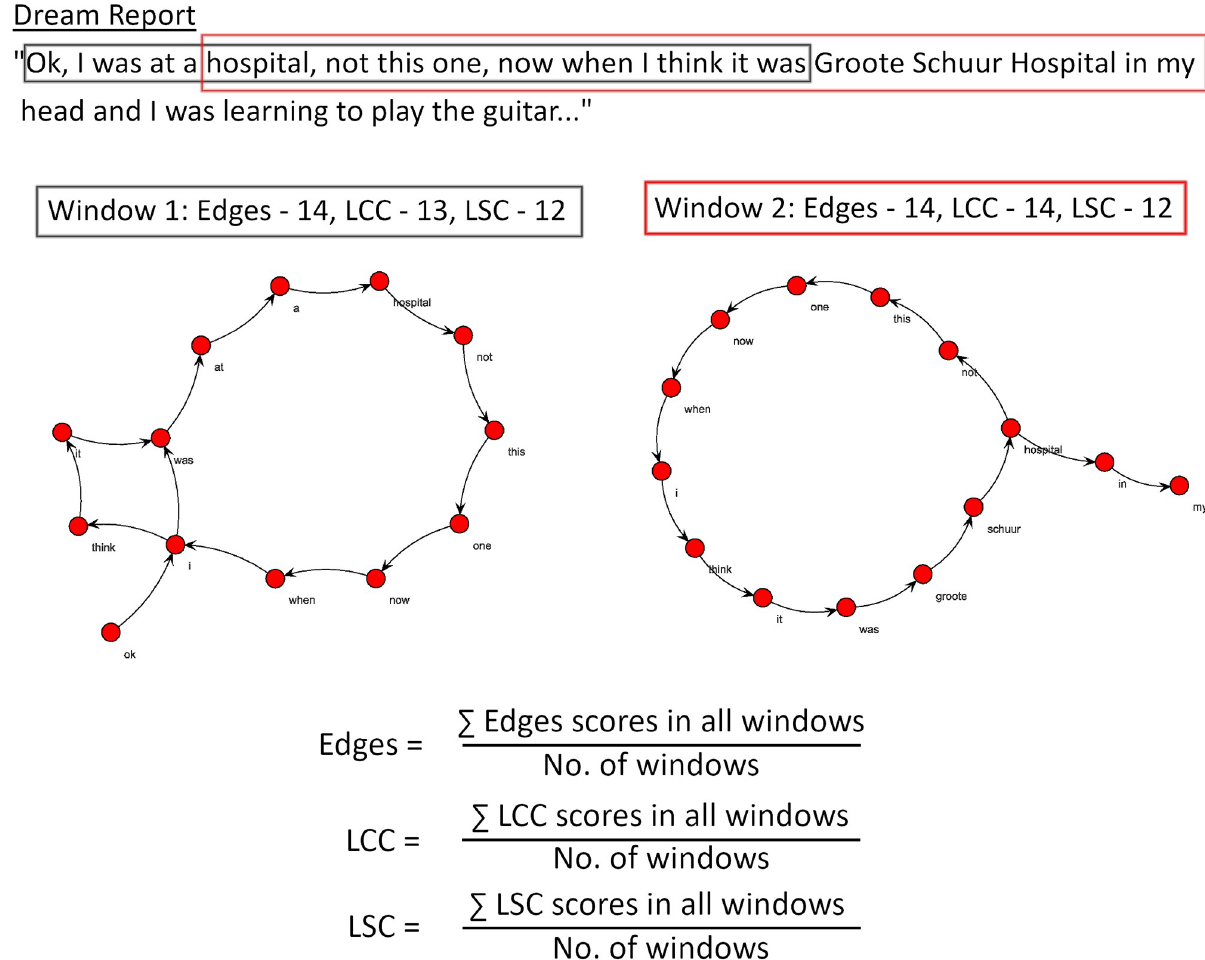
Fig 2. Illustration of the sliding window method. This example uses a window length of 15 words and an overlap of 10 words. While graphs from the first two windows are shown here, the window is applied across the entire dream report, after which an overall average is calculated.